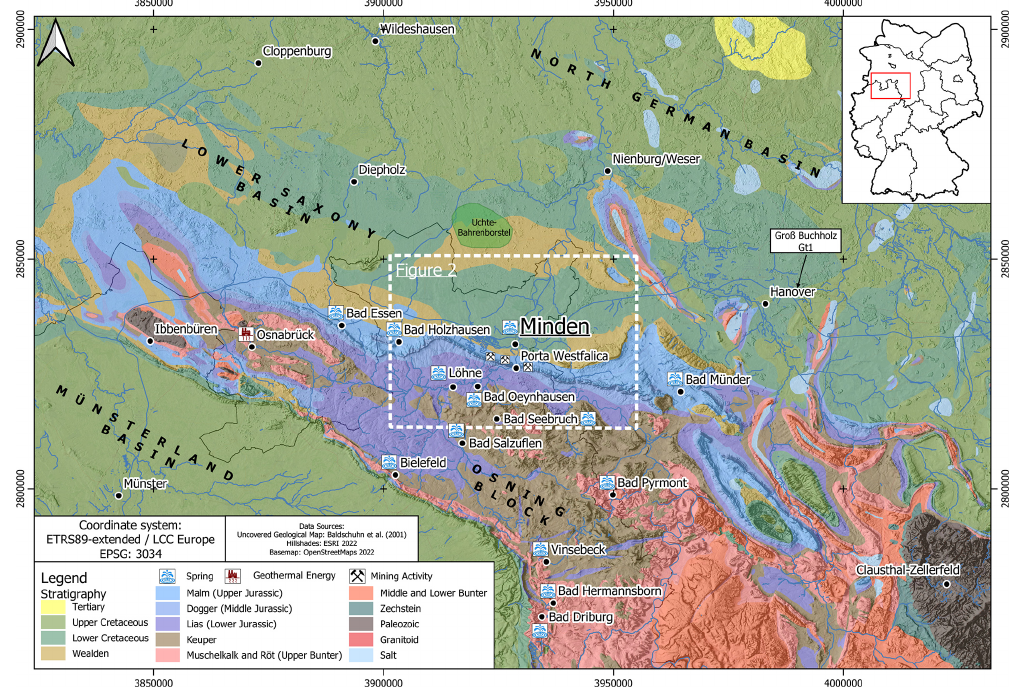
Figure 1. Uncovered geological overview map of the southern margin of the Central European Basin (Baldschuhn et al., 2001; Littke et al., 2008). Springs in several cities on the Osning Block are indicated (Michel et al., 1998). Mining locations in the city of Minden are indicated (Deutloff et al.,